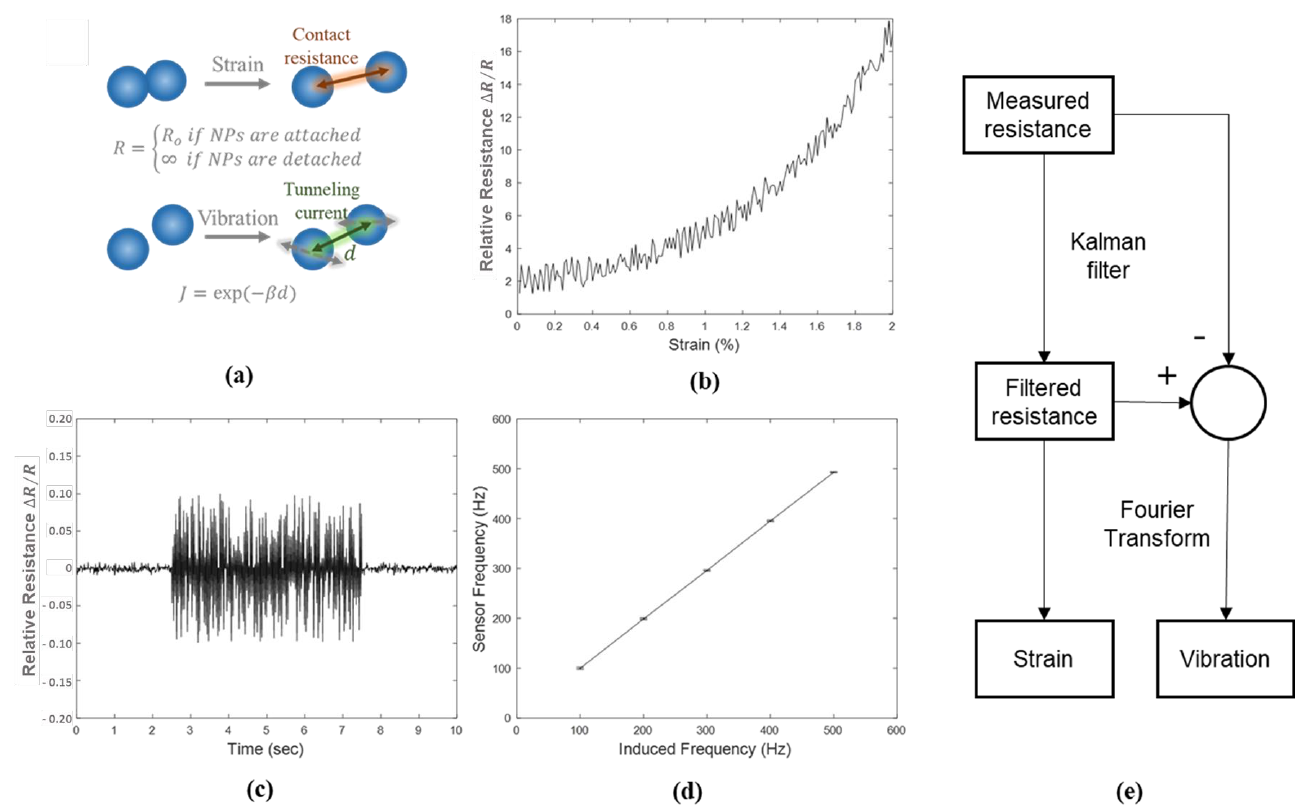
Figure 2. ( a ) Schematic diagram of the sensing mechanism of the nanoparticle sensor for strain and vibration measurement, respectively. ( b ) Relative resistance changes of sensor according to strain. ( c ) Relative resistance changes during continuous vibration with a frequency of 200 Hz by the vibration shaker. ( d ) Peak frequency of sensor resistance obtained by fast Fourier transform (FFT) at Q-level of 70.7% with respect to the induced frequency. ( e ) Flowchart of proposed interoperable strain and vibration measurement.